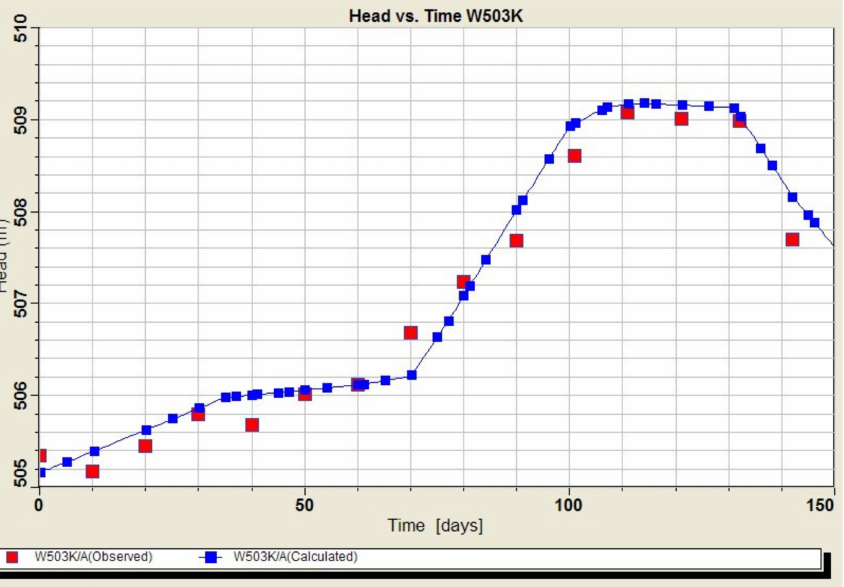
Figure 8. Model calibration vs. observed groundwater head fluctuations in the W503K observation well, from April 2017 to November